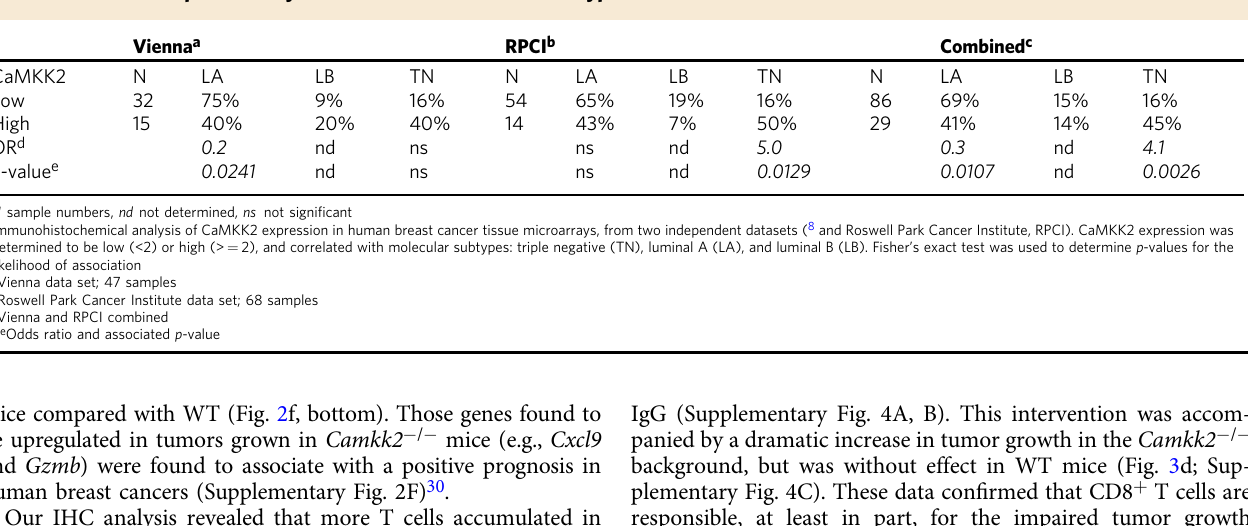
Table 1 CaMKK2 expression by molecular breast cancer